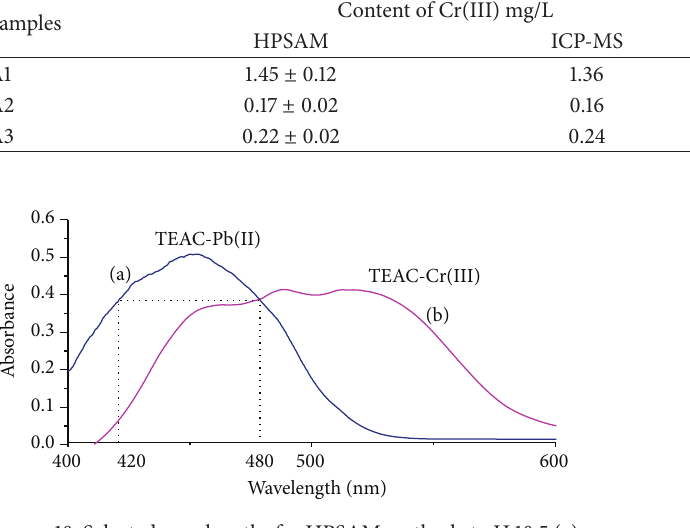
Table 2: Results of simultaneous determination of the analysis of Cr and Pb ions in the plating wastewater (mg/L). Samples